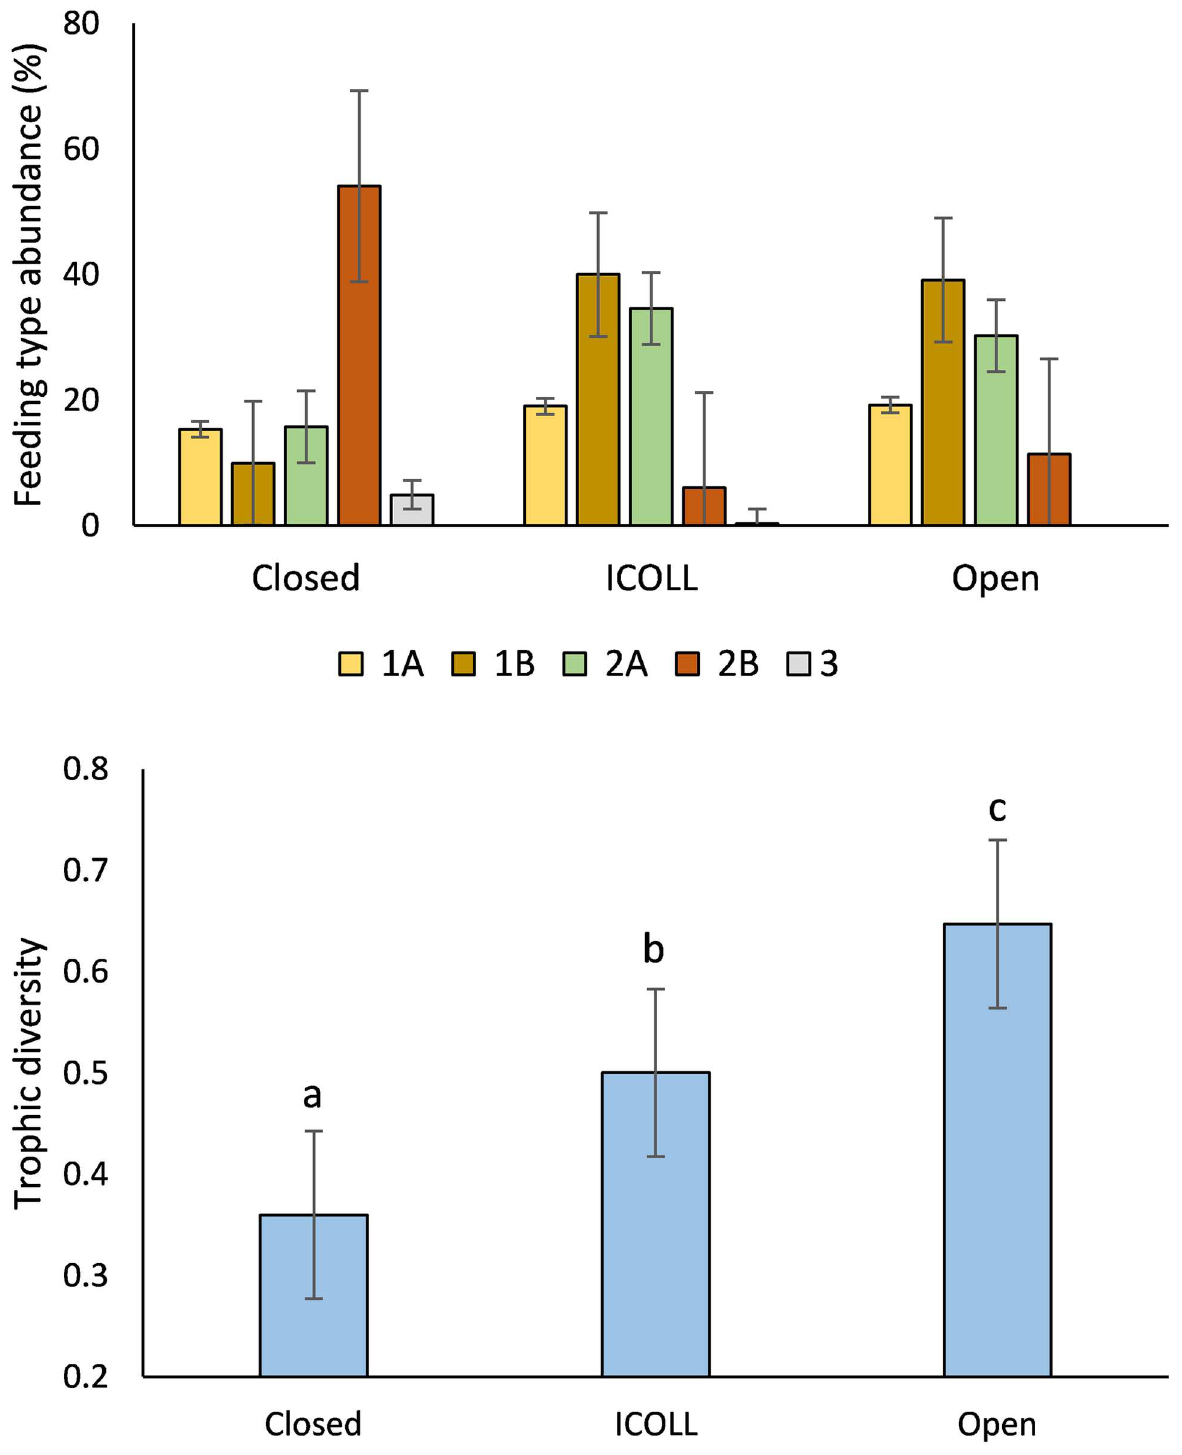
Fig 4. Relative abundance of nematode feeding types and index of trophic diversity (mean ± SE) in closed, intermittently open/ closed (ICOLL) and open lagoons. Different letters indicate significantdifferences (p < 0.05)among lagoontypology. (1A) selective depositfeeders, (1B) nonselective depositfeeders, (2A) epigrowth feeders, (2B) predators/omnivoresand (3) vascular plant feeders.